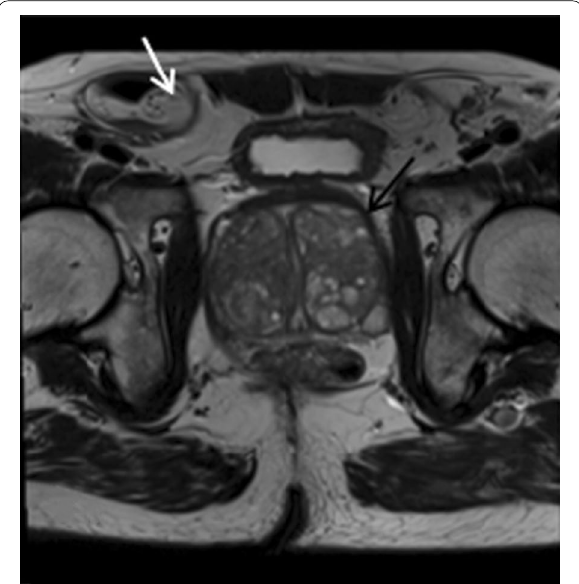
Fig. 20 Axial T2W images demonstrate a moderately high T2 signal mass in the right inguinal region (white arrow) which was contiguous